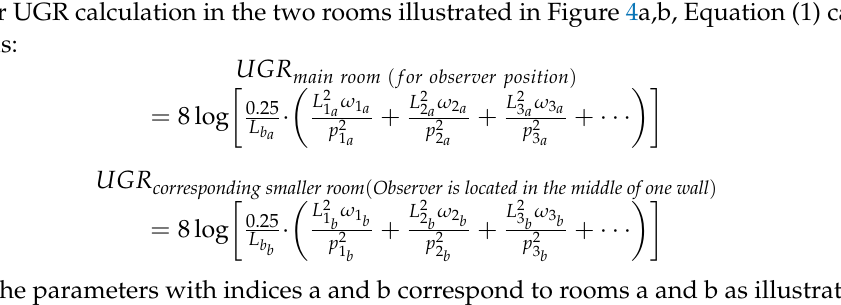
Figure 4. ( a ) Observer in a position in a room in which some of the luminaires are in front of them (in their field of view), ( b ) observer in a room which contains only the luminaires that are in the first observer’s field of